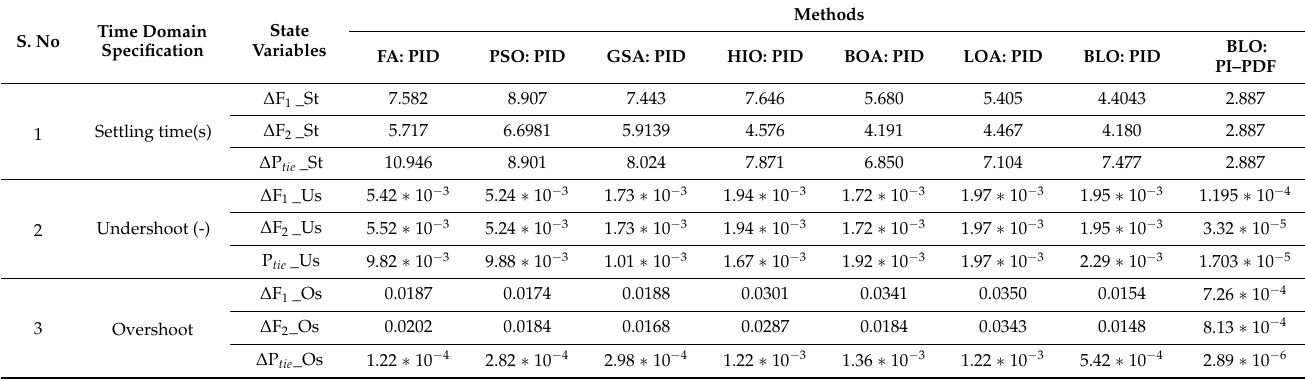
Table 5. Time domain analysis of power system for